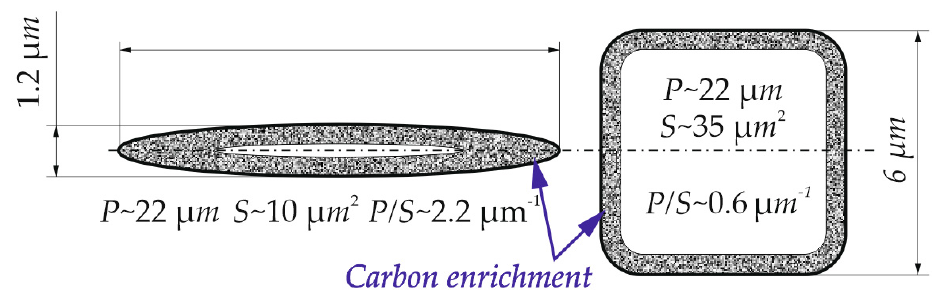
Figure 11. A simplified diagram showing the geometric differences in layer and blocky grain morphologies; S—surface area of grain; P—grain perimeter; ~—approximate value.